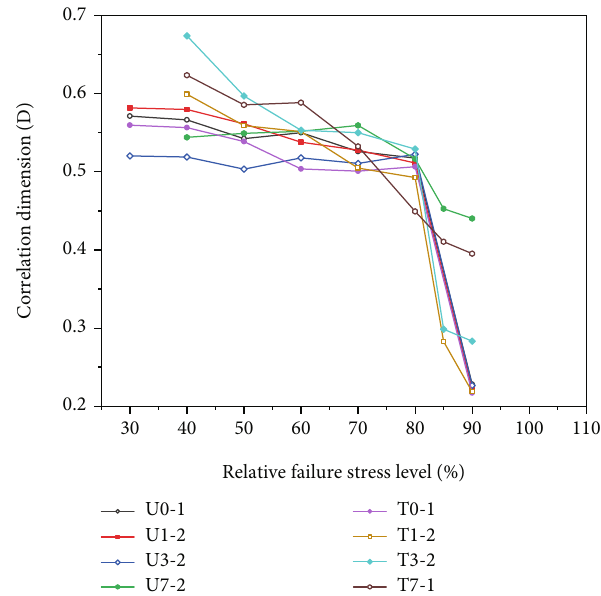
Figure 13: Relationships between stress percentages and correlation dimension values for di ff erent moisture